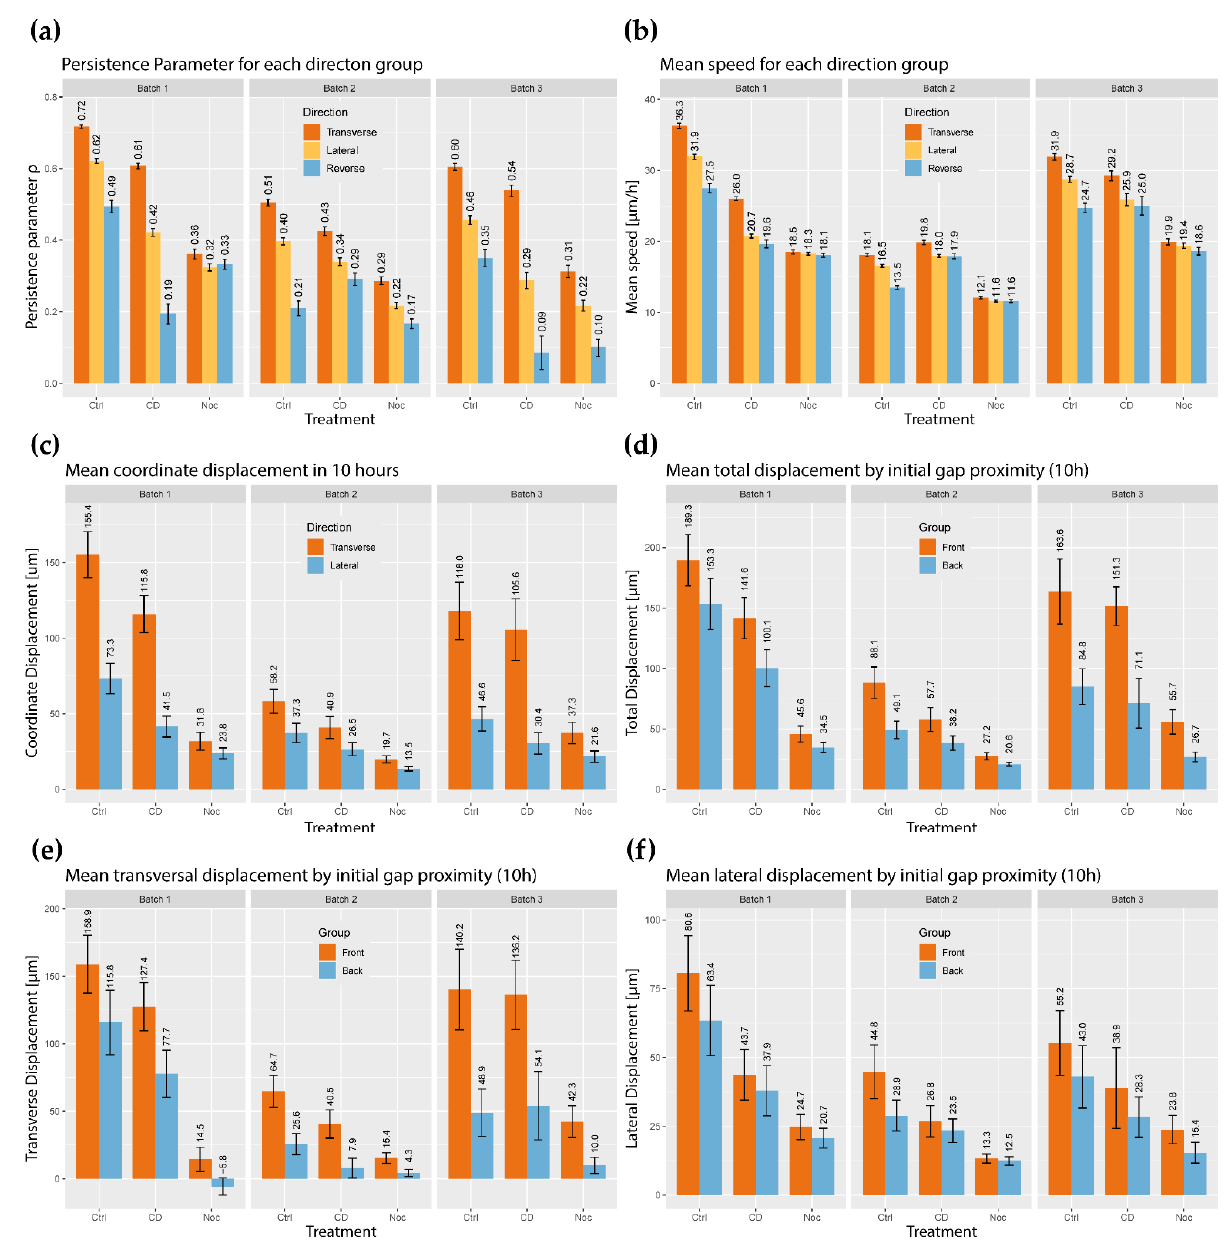
Figure 4. ( a ) Persistence parameter for each direction group; ( b ) Mean speed calculated for motion in each direction group; ( c ) Mean coordinate displacement in 10 h by direction grouping. The reverse direction was excluded from the visualization due to few samples (see Supplementary Materials); ( d ) Mean total displacement in 10 h by initial proximity to the wound gap; ( e ) Mean transversal (orthogonal to the leading edge) displacement in 10 h by initial proximity to the wound gap. As described in Figure 1, the ideal motion for wound healing is positive coordinate displacement along the transverse axis; ( f ) Mean coordinate displacement of the lateral component (parallel to the leading edge) in 10 h by initial proximity to the wound gap. The error bars represent the 95% confidence interval. Definitions for the displacement and total displacement can be found in the framework section.